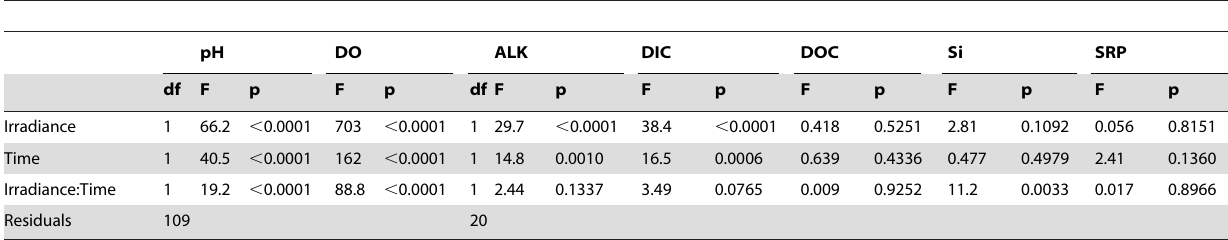
Table 3. The effects of time of sampling (morning vs. afternoon) and treatment factors (light vs shade) on water chemistry in the laboratory